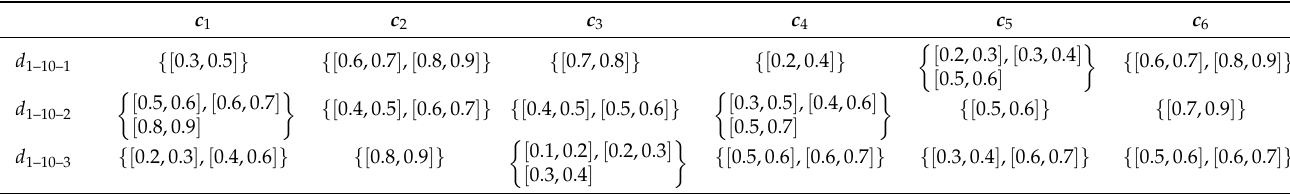
Table A10. Scoring matrix of business risk d 1–10 .